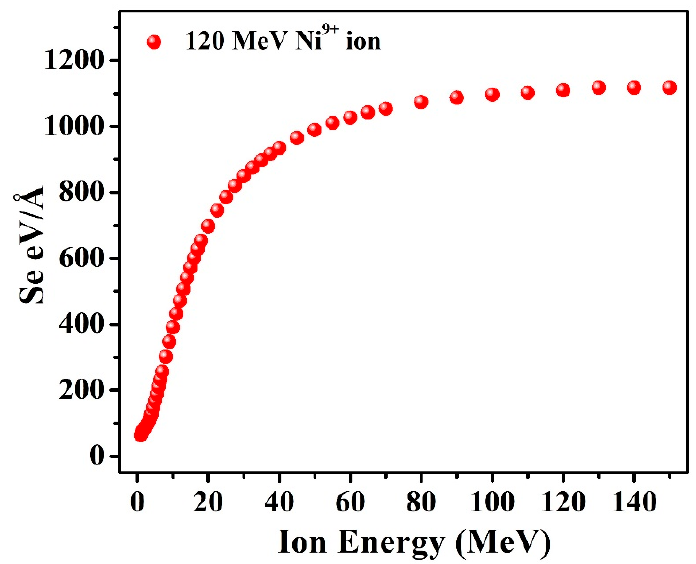
Figure 1. The calculated electronic energy loss (S e ) using SRIM simulations.